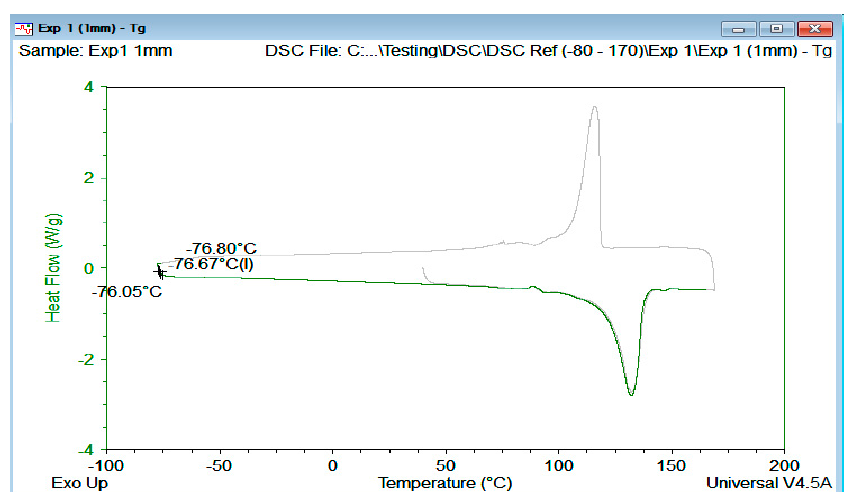
Figure A3. T g of HDPE after Experiment 2.